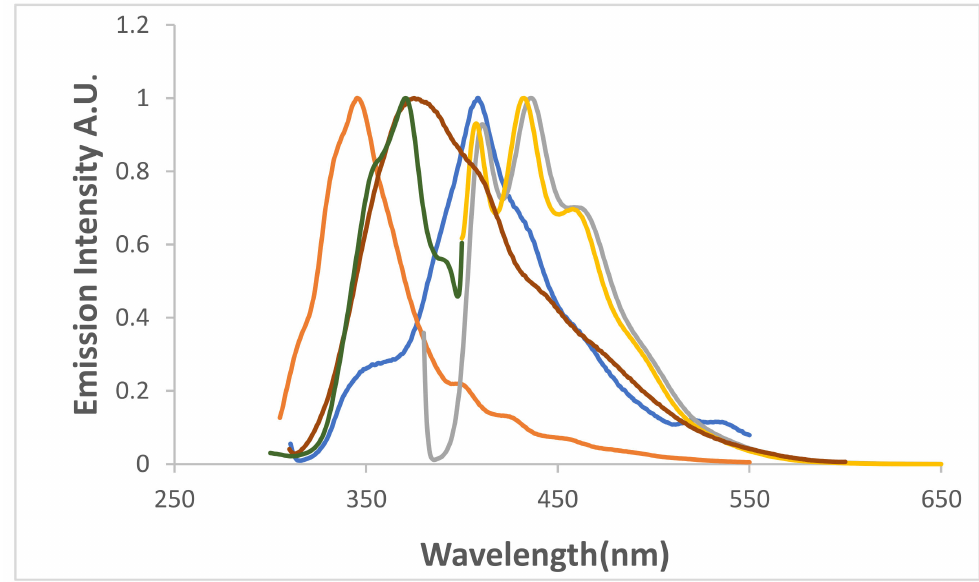
Figure 9. Normalized emission spectra of 7.6 × 10 − 5 M of 2-amino-4-hydroxy-6-(4-hydroxy-2-oxo-